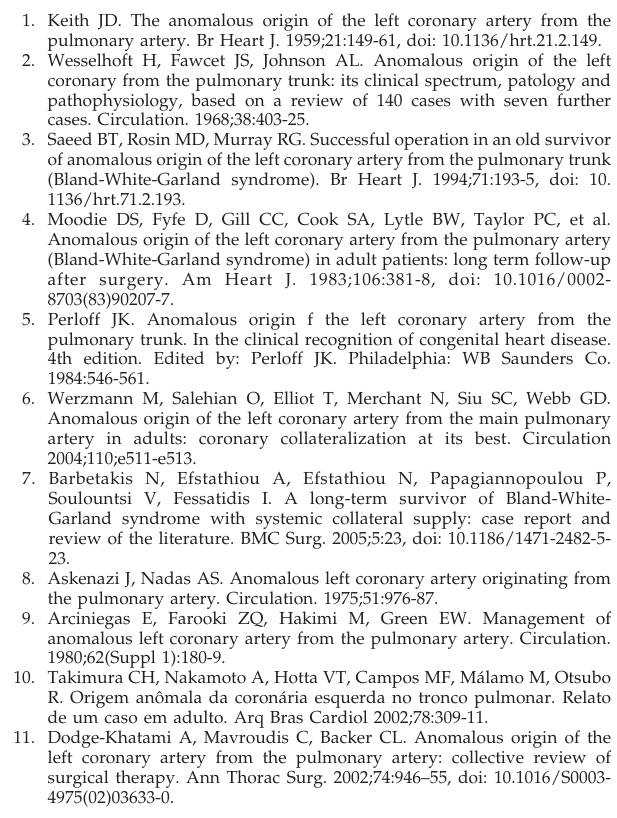
Figure 2 - Magnetic resonance angiography of the coronary arteries with 3D reconstructions showing the ostia of the coronary arteries. Note that the left coronary artery has its origin in the pulmonary trunk (TAP – trunk of pulmonary artery, Ao - ascending aorta, LA - left atrium, Cx - circumflex coronary artery, DA - left anterior descending coronary artery, CD - right